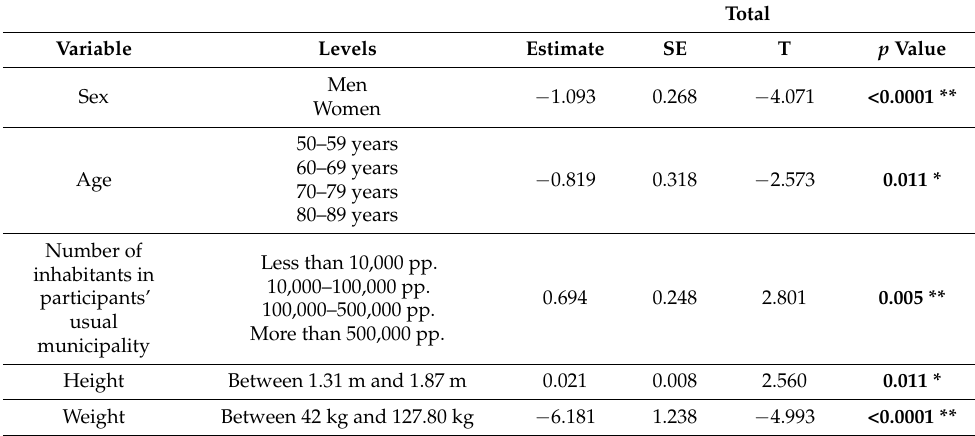
Table 4. Regression coefficients for the loneliness (SOLTOT)